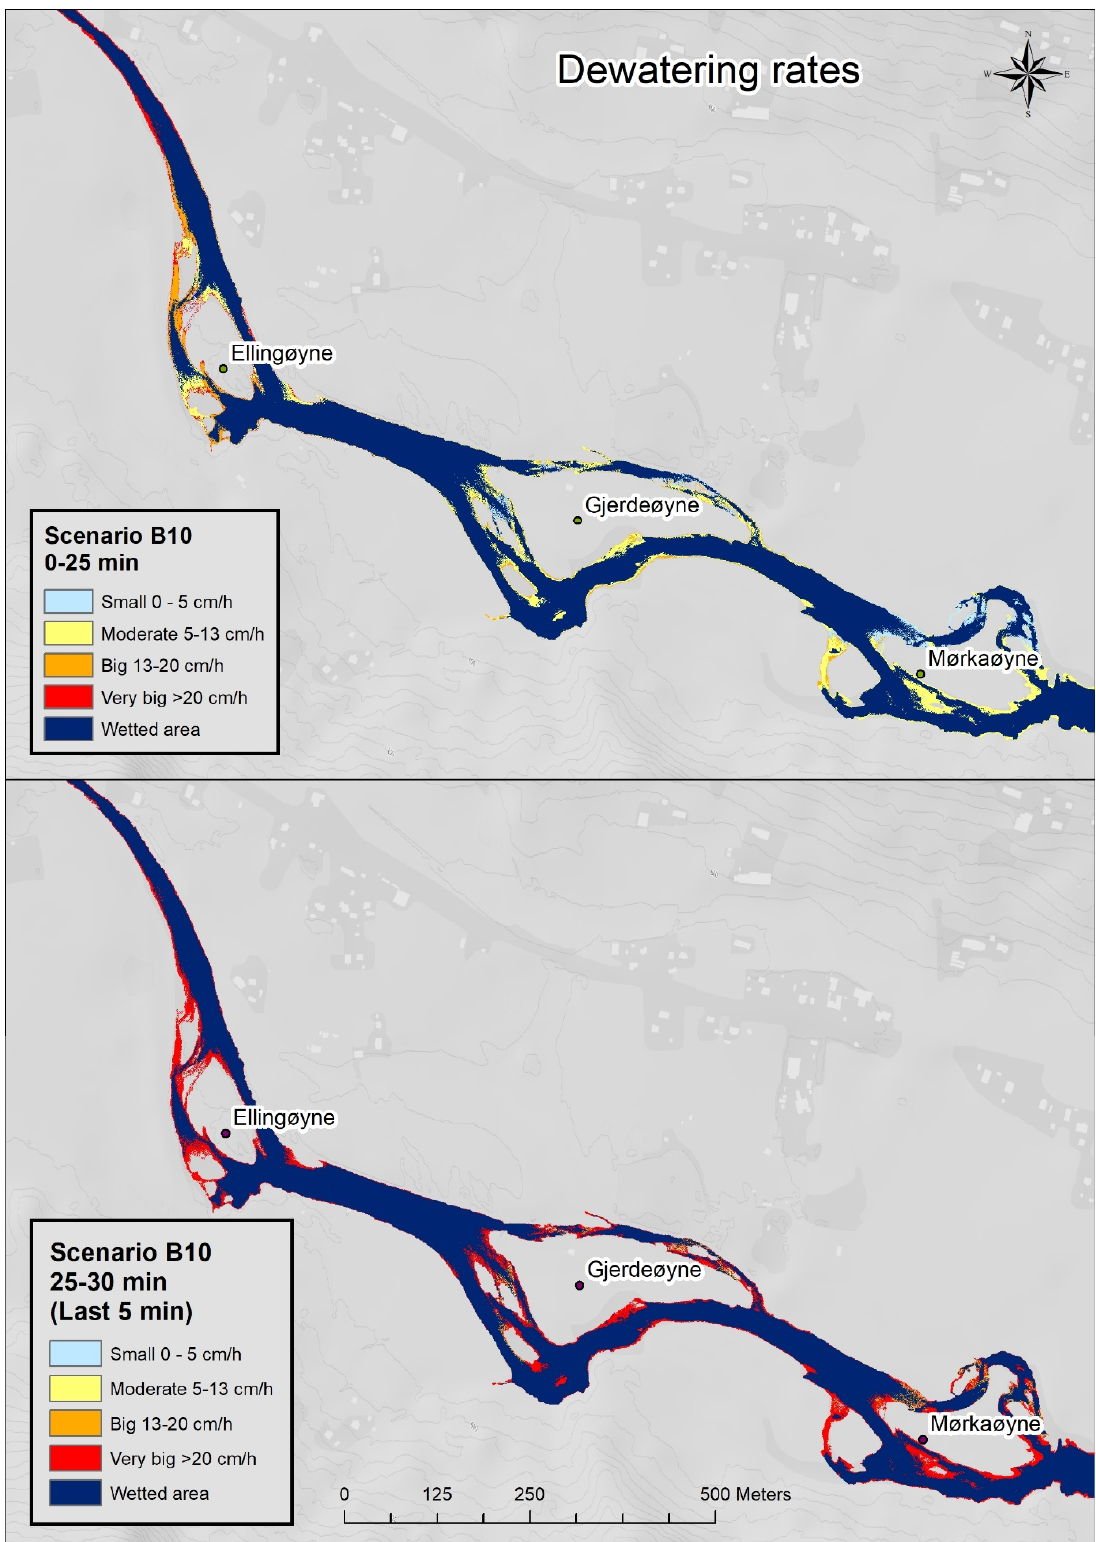
Figure A2. Dewatering rates scenario B10.